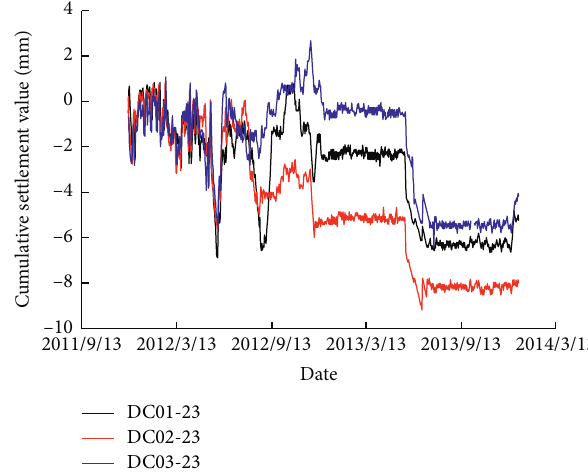
Figure 6: Settlement change curve of the construction company DC01-23 ∼ DC03-23 at Wannianquan Road Table 4: Settlement changes of the surface subsidence monitoring point of Wannianquan Road Station in different stages. Stages of change Cumulative settlement value (mm) Cumulative change (mm) Proportion of total settlement (%)